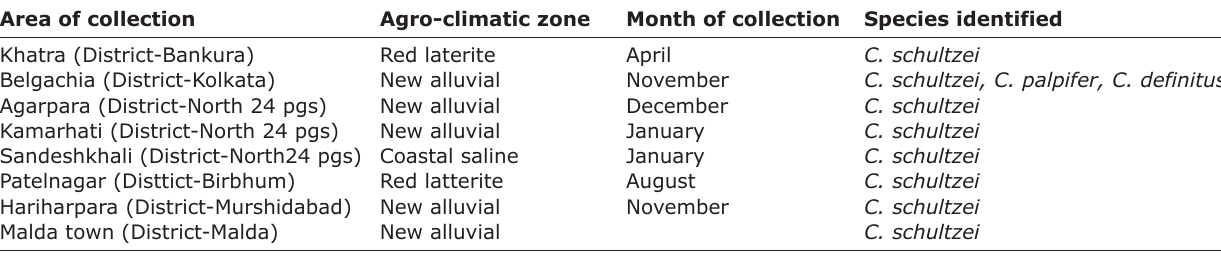
Table-4: Identification of Culicoides species from different areas of South Bengal. Area of collection